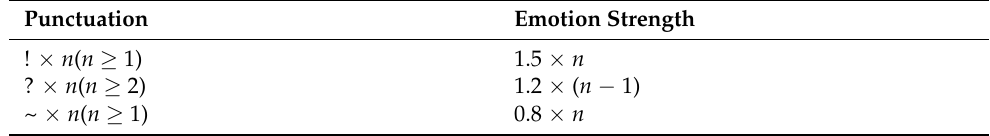
Table 12. Emotion strength of